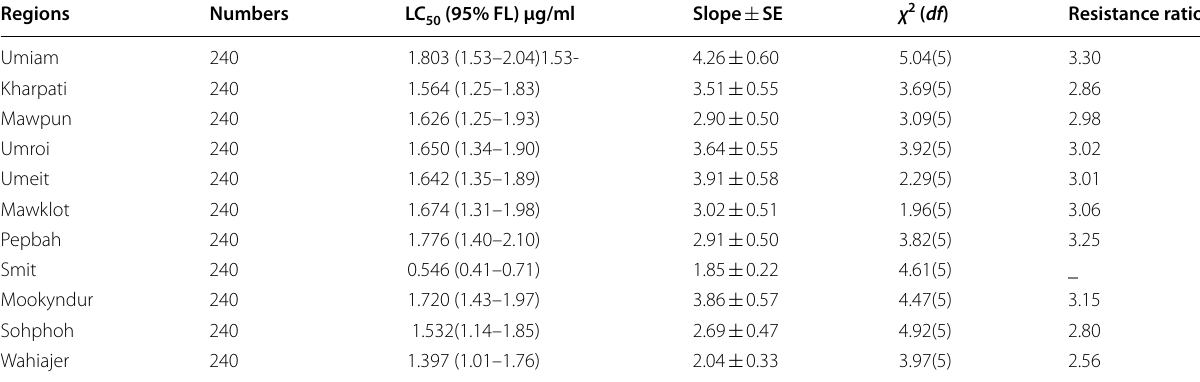
Test for heterogeneity; χ 2 value was significant at 5% level of significance for a goodness-of-fit test for each regression SE, Standard error; N, No. of test insects; 95% FL, 95% fiducial limits